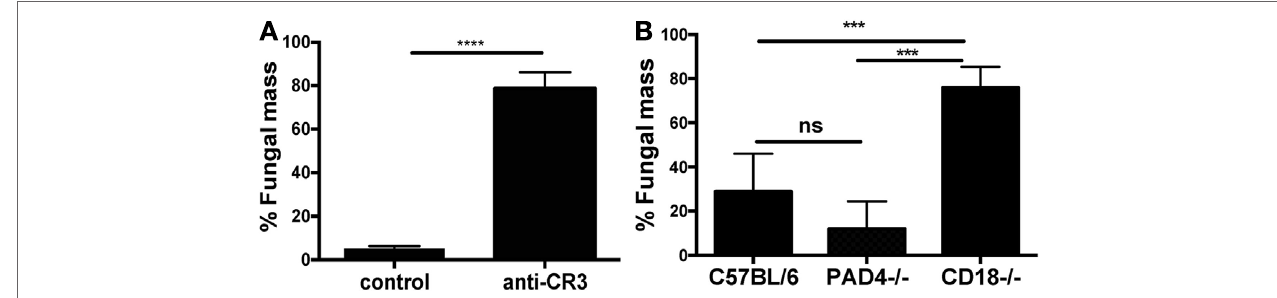
FigUre 7 | CR3, but not protein deiminase 4 (PAD4), is required for neutrophil inhibition of Aspergillus fumigatus hyphal growth. (a,B) A. fumigatus hyphae incubated 18 h with human neutrophils in RPMI alone or with anti-CR3 M1/70 (20 μ g/ml) (a) . Fungal mass was quantified by calcofluor white fluorescent chitin stain and presented as percent of total hyphae in the absence of neutrophils. (B) Percent fungal mass in bone marrow neutrophils from C57BL/6, CD18 − / − , or PAD4 − / − mice following 18 h incubation with A. fumigatus hyphae. p Values are biological replicates of three repeat experiments and were calculated using Student’s t -test (a) or ANOVA with a Tukey post hoc analysis (B) (**** p < 0.0001; *** p < 0.001; ns, not